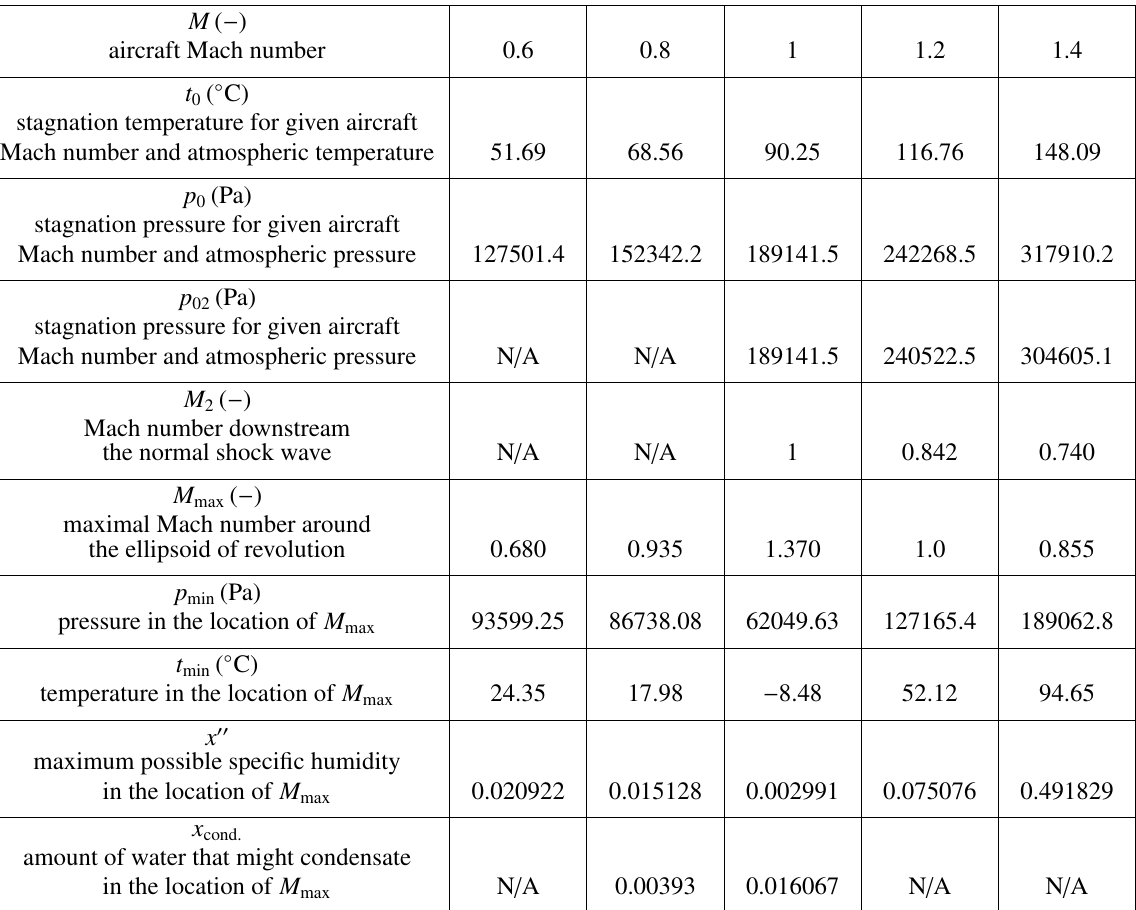
Table 4. The following table summarizes the results of calculations for a simple case of flow past ellipsoid of revolution in the moist air